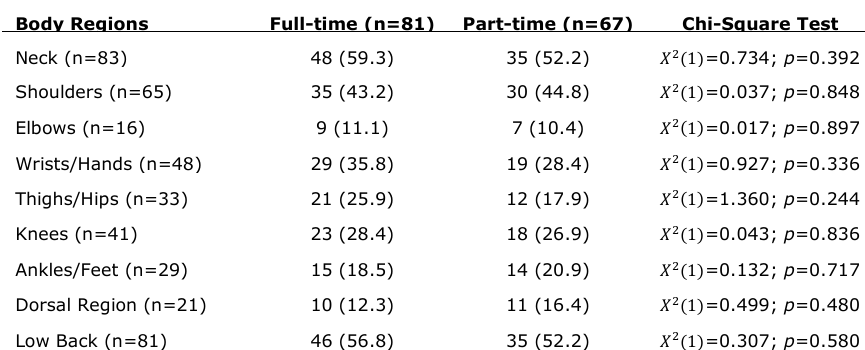
Table 4. Association between musculoskeletal symptoms and work hours